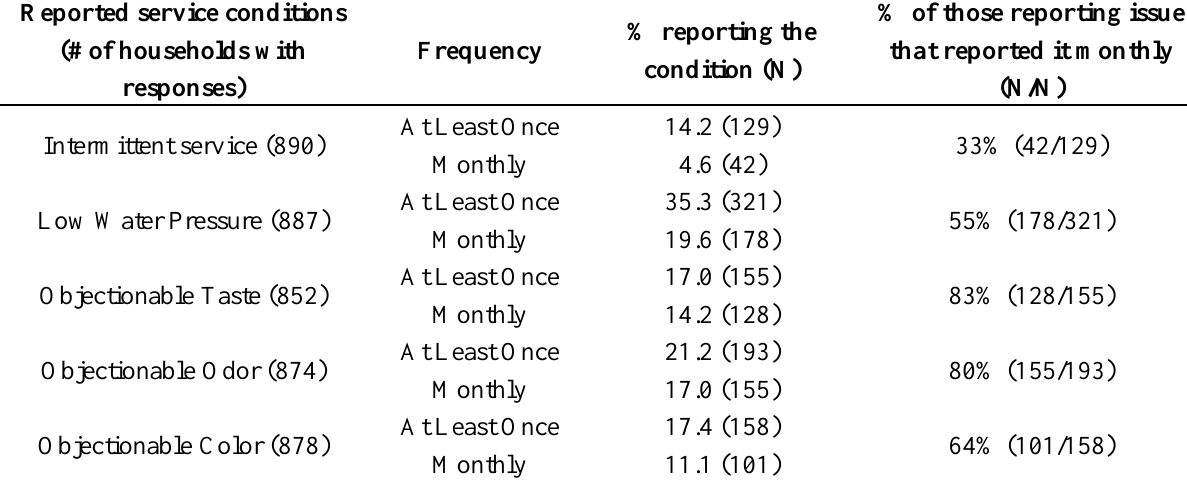
Table 1. Perceptions of water service conditions in a survey of 910 households in rural